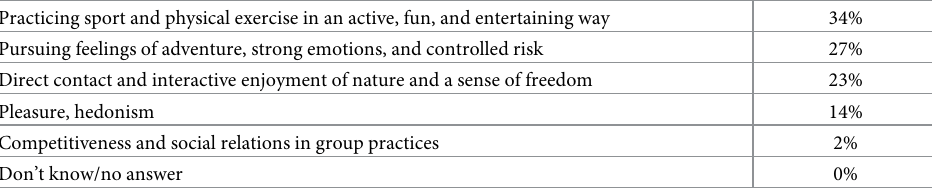
Table 2. Primary user motivations for practicing outdoor physical sports activities from the perspective of supply. Practicing sport and physical exercise in an active, fun, and entertaining way 34% Pursuing feelings of adventure, strong emotions, and controlled risk 27% Direct contact and interactive enjoyment of nature and a sense of freedom 23% Pleasure, hedonism 14% Competitiveness and social relations in group practices 2% Don’t know/no answer